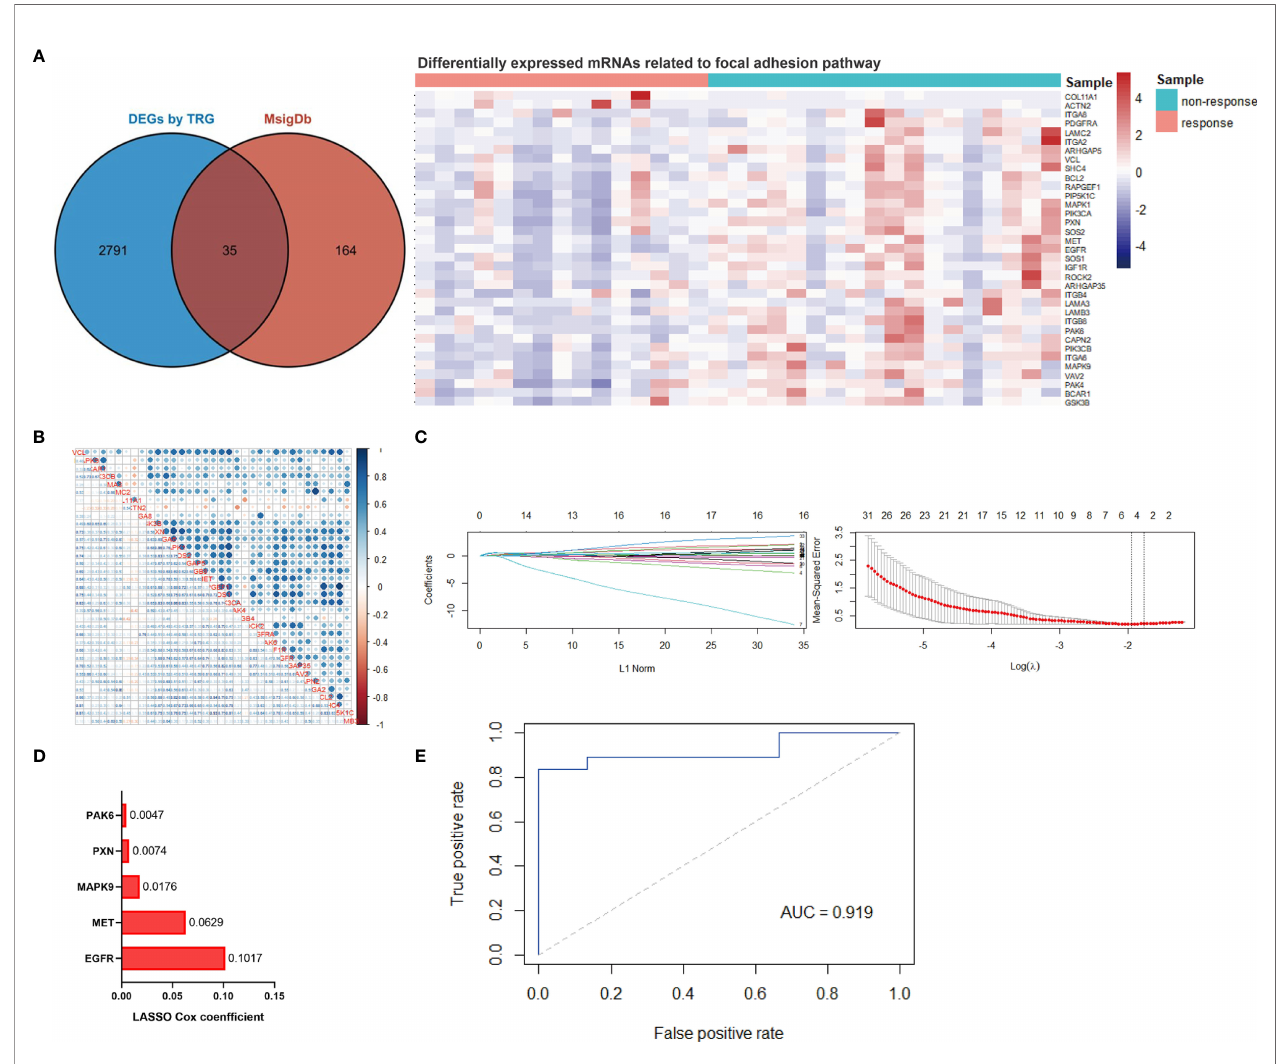
FIGURE 2 | Establishment of the focal adhesion-related gene signature for predicting ef fi cact to chemotherapy in patients with gastric cancer. (A) Thirty- fi ve focal adhesion-related genes were identi fi ed among the DEGs between responders and non-responders to chemotherapy. (B) The linear correlation analysis of 35 identi fi ed focal adhesion-related genes. (C) The most robust predictive genes were identi fi ed using the least absolute shrinkage and selection operator (LASSO) Cox regression algorithm. (D) An ensemble of 5 genes remained with nonzero coef fi cients. (E) Receiver operating characteristic (ROC) analysis for the predictive power of the focal adhesion-related gene signature, and the area under the ROC curve was